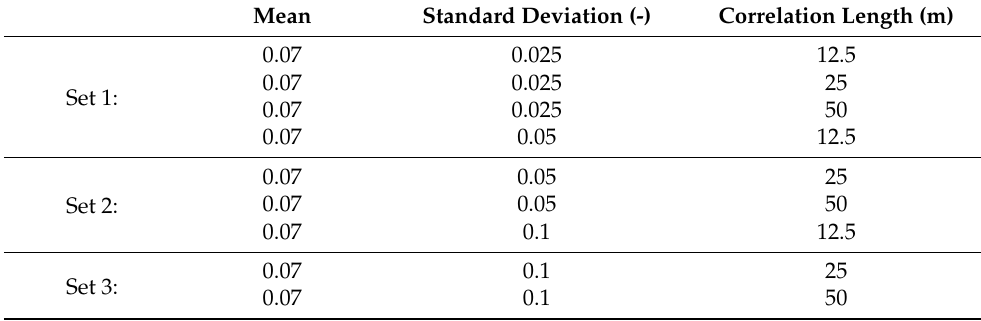
Table 2. Simulation plan of the porosity field.